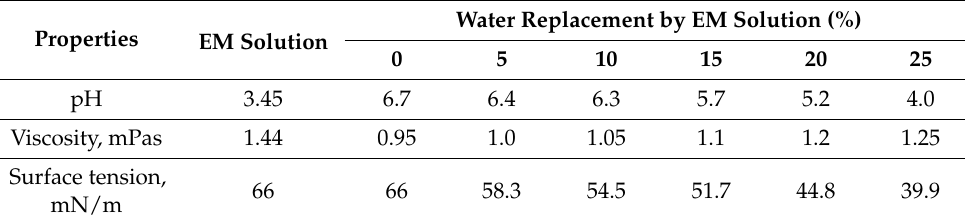
Table 4. Prepared EM solution properties (pH, viscosity, and surface tension).